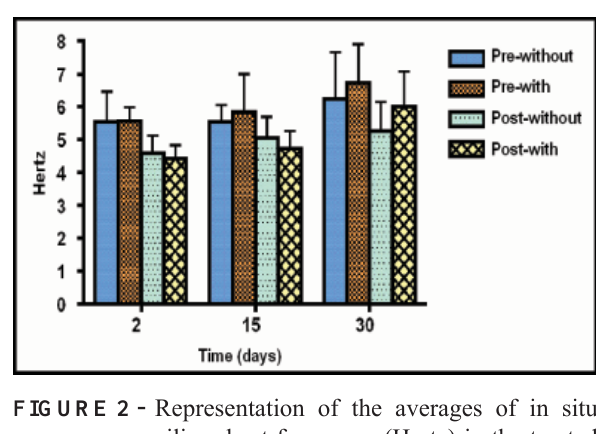
FIGURE 2 - Representation of the averages of in situ ciliary beat frequency (Hertz) in the treated and control groups, according to the pre and post-anastomotic site, in 2, 15 and 30 days after transplantation (p > 0.05). Without = without the administration of cyclosporine; With = with the